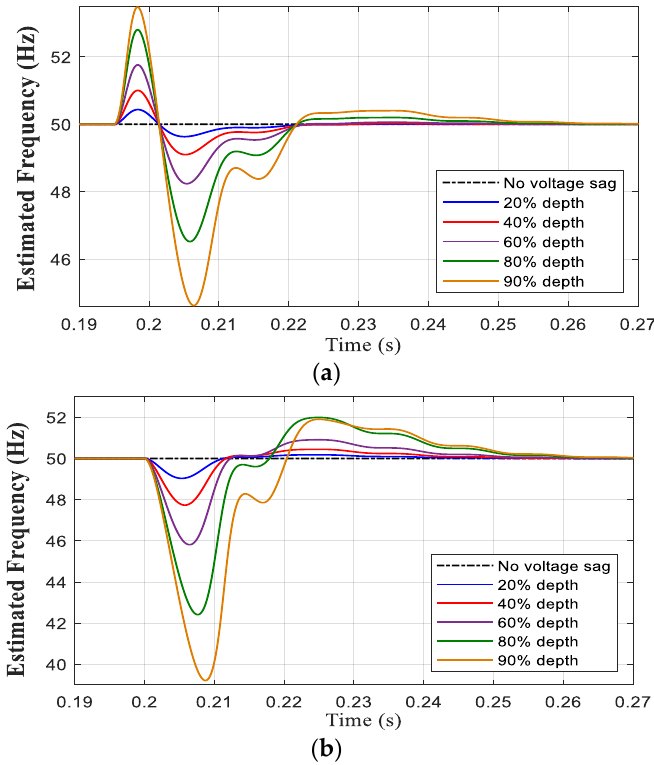
Figure 2. Perturbations induced in the SOGI-FLL estimated frequency for different voltage sag depths: ( a ) at non-zero input voltage; ( b ) at zero crossing input voltage.